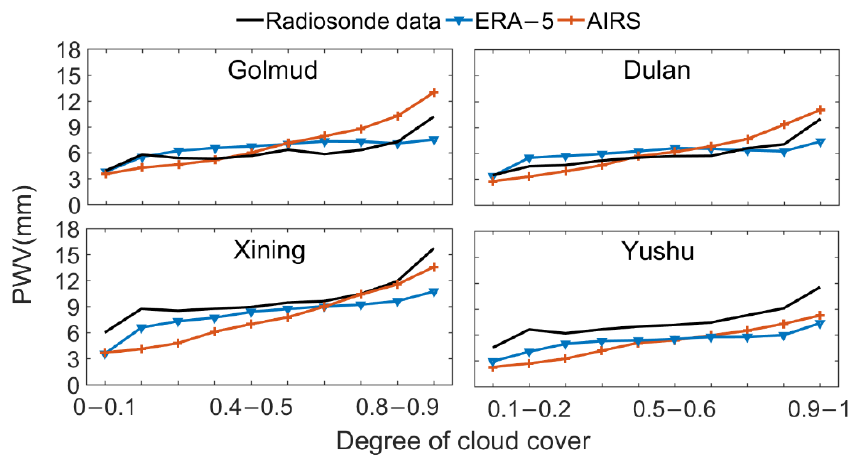
Figure 9. PWV of ERA-5, AIRS, radiosonde data under different total cloud cover at different stations. Compared with ERA-5 data, AIRS data have greater differences compared with the radiosonde data in terms of PWV, total cloud cover, and PWV under different total cloud cover levels. Therefore, only ERA-5 data and radiosonde data were compared and analyzed in the subsequent analysis. It should be noted that one advantage of AIRS data over ERA-5 data is that the former can better reflect the increasing trend of PWV with increasing cloud